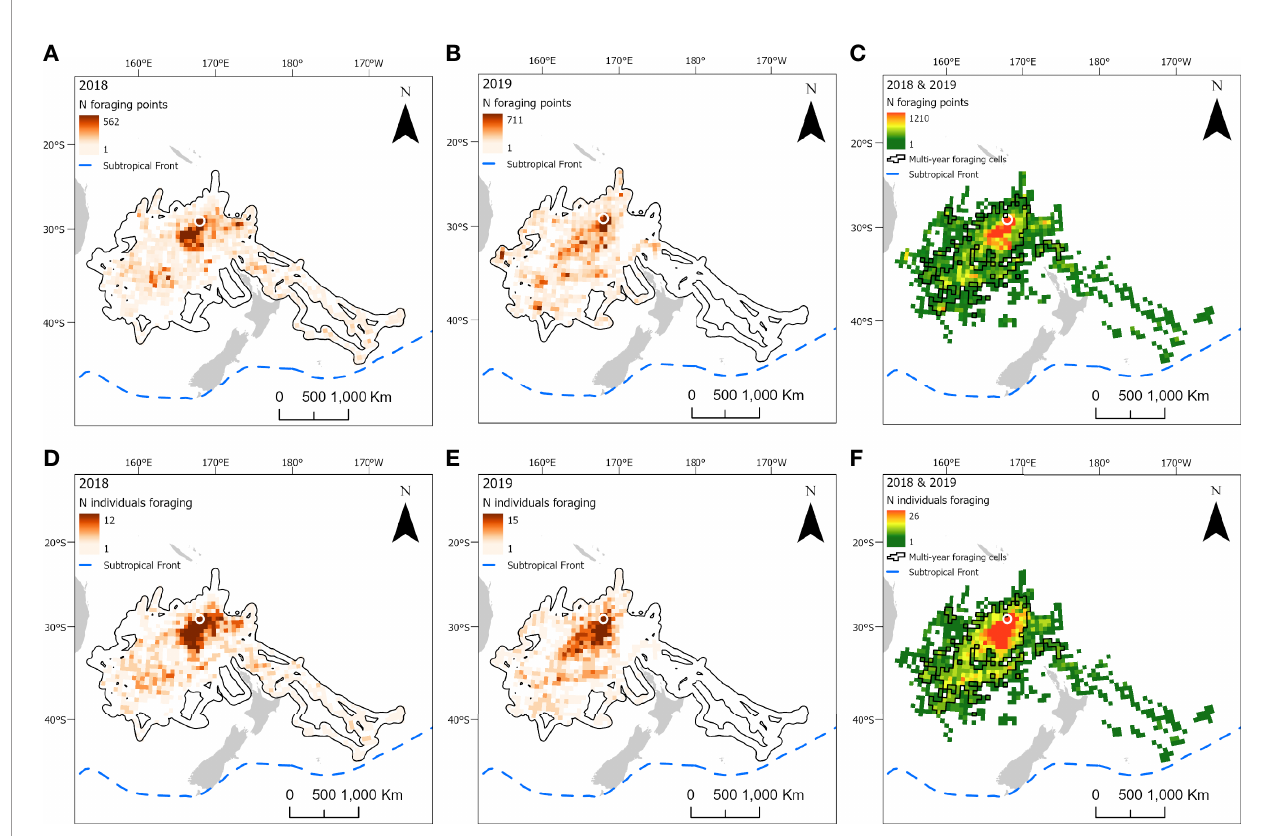
FIGURE 5 | At-sea distribution and locations of foraging behavior in chick-provisioning white-necked petrels ( Pterodroma cervicalis ). Grid cells (50 x 50 km) represent the number of foraging locations in 2018 ( A ; n = 12 individuals) and 2019 ( B ; n = 15 individuals) and combined number of foraging locations in 2018 and 2019 (C) . Number of individuals foraging in each grid cell in 2018 (D) and 2019 (E) ; and the combined number of individuals foraging in each grid cell in both 2018 and 2019 (F) . Polygonised cells in C and F represent grid cells in which birds foraged in both years. The location of the breeding colony is represented by a white circle. Black polygons around the foraging areas (A, B, D, E) represent the home range (99% utilization distribution). The approximate location of the Subtropical Front is represented by a dashed blue